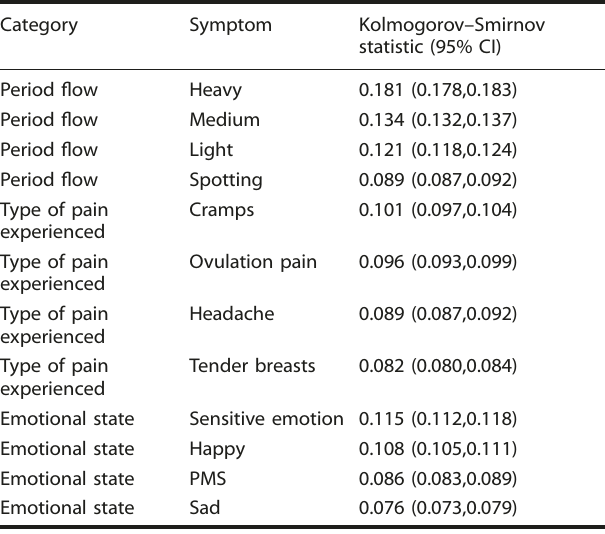
Table 4. Kolmogorov – Smirnov test results for symptom tracking patterns.